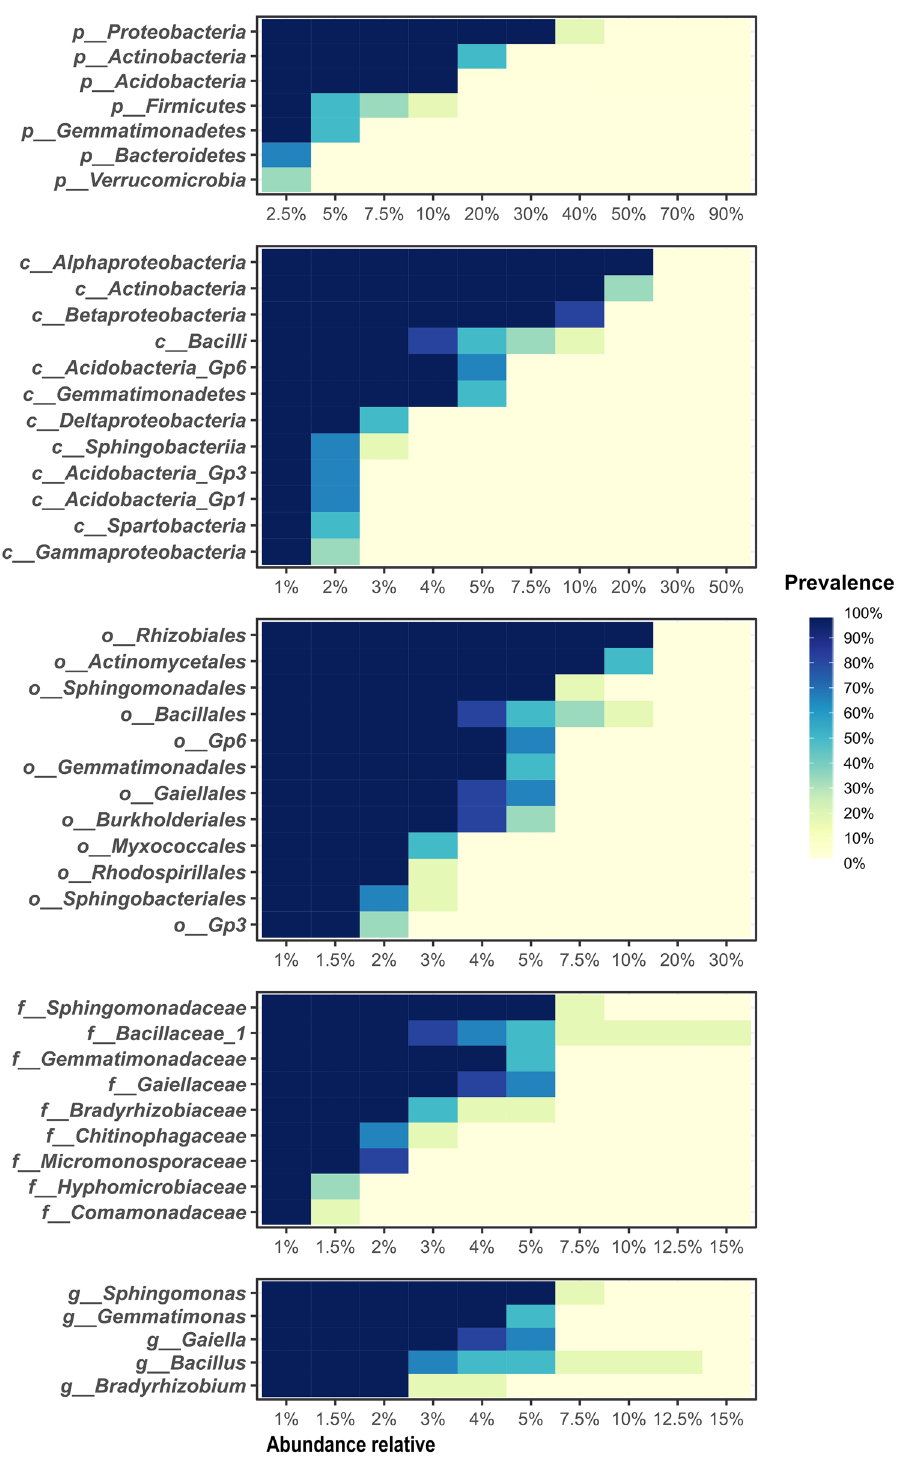
Figure 6. Core microbiome analysis of sugarcane rhizosphere. High prevalence prokaryotic taxa (> 90%) in the rhizosphere samples, regardless of the farming system, where the blue color indicates the prevalence of taxa in the samples and the horizontal percentage represents the relative abundance of each taxon in the respective sample. The taxonomic level can be identified by the prefixes: “p” (phylum), “c” (class), “o” (order), “f” (family), and “g”